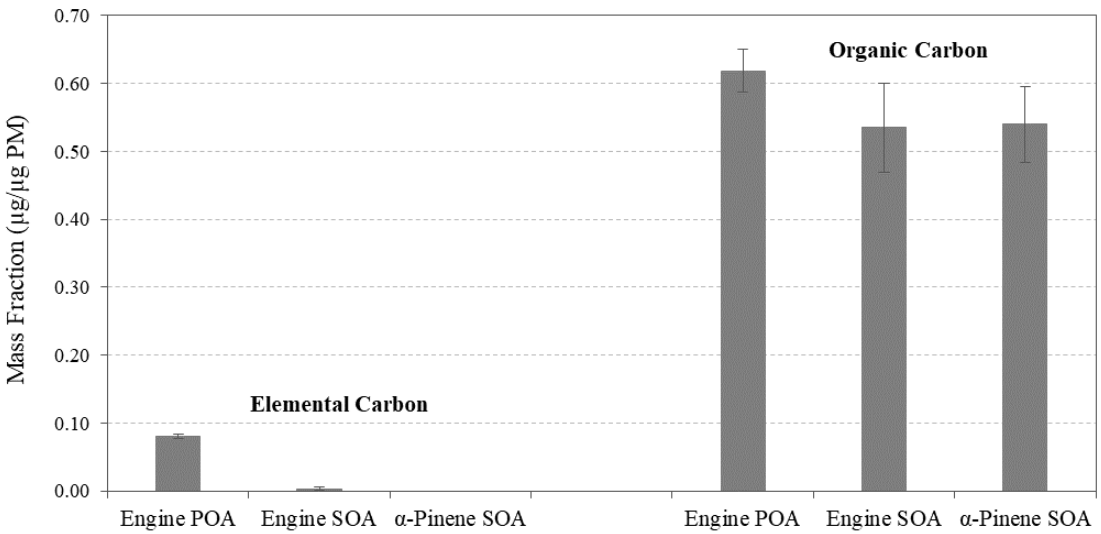
Figure 3. Mass fractions of elemental carbon (EC) and organic carbon (OC) in engine primary organic aerosol (POA) and engine & α -pinene secondary organic aerosols (SOA). Error bars represent laboratory uncertainty values based on contributions of analytical error (standard deviation) and blank subtraction (standard deviation of at least three method